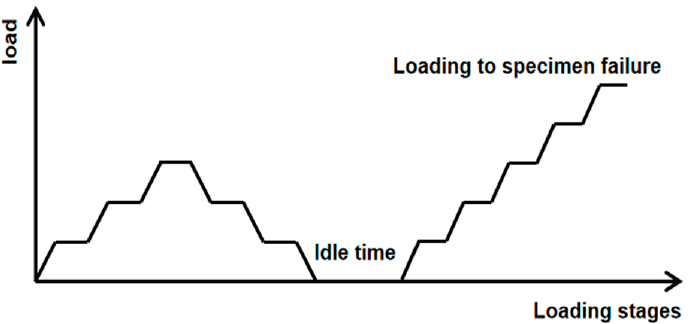
Figure 8. Loading mode diagram.